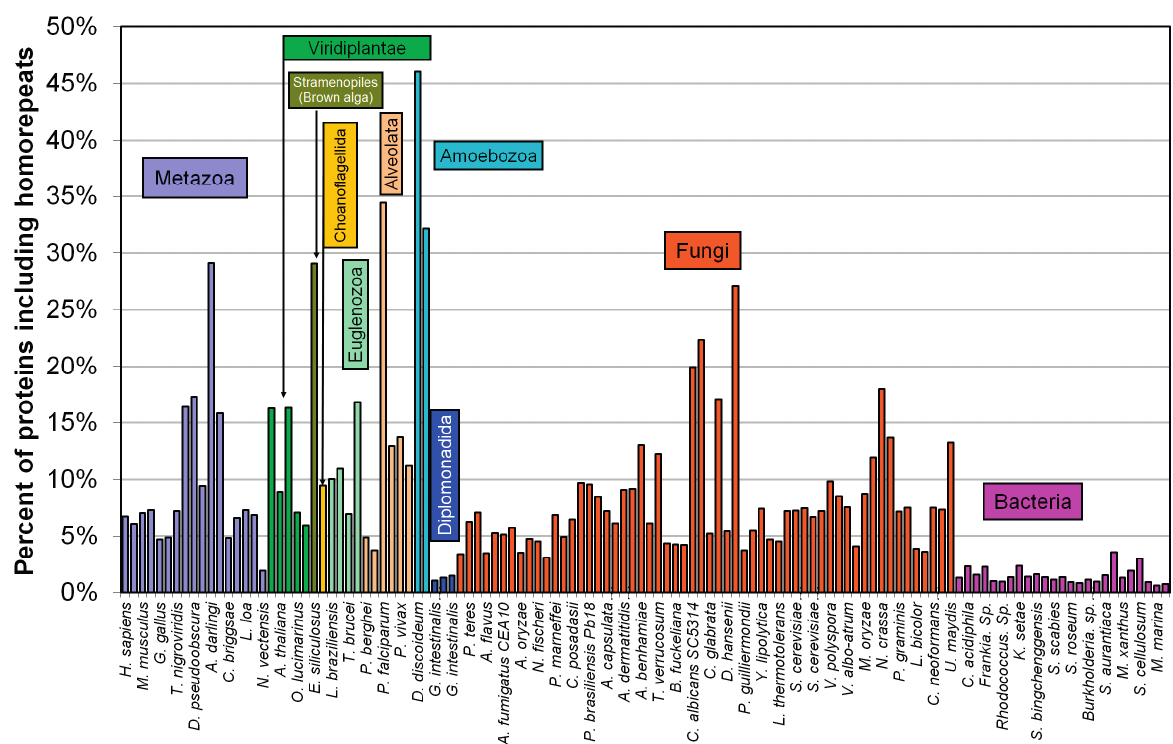
Figure 2. Percent of proteins including homo-repeats for 122 proteomes.